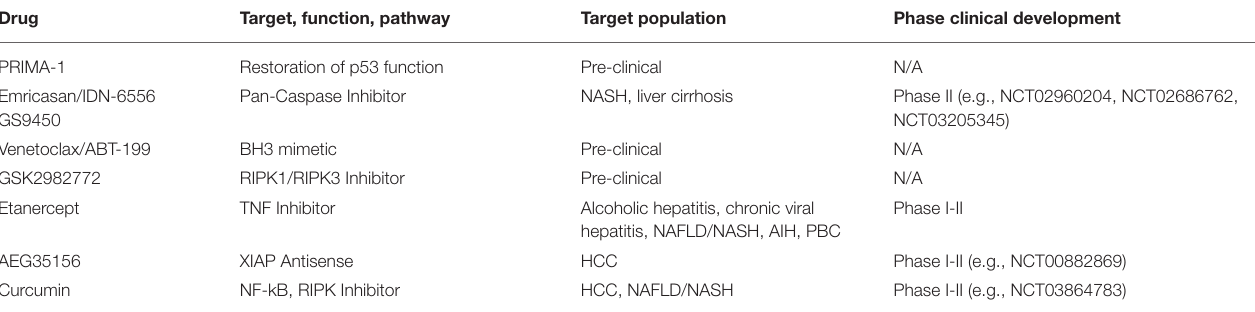
TABLE 1 | Selected targets of cell death in liver diseases and cancer.